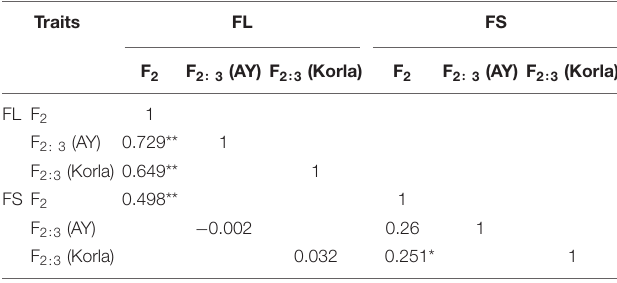
TABLE 3 | Correlation coefficients corresponding to five fiber quality traits in the primary study populations.